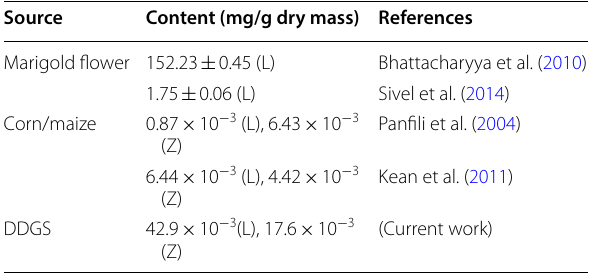
Table 3 Comparison of lutein (L) and zeaxanthin (Z) in marigold, corn, and DDGS